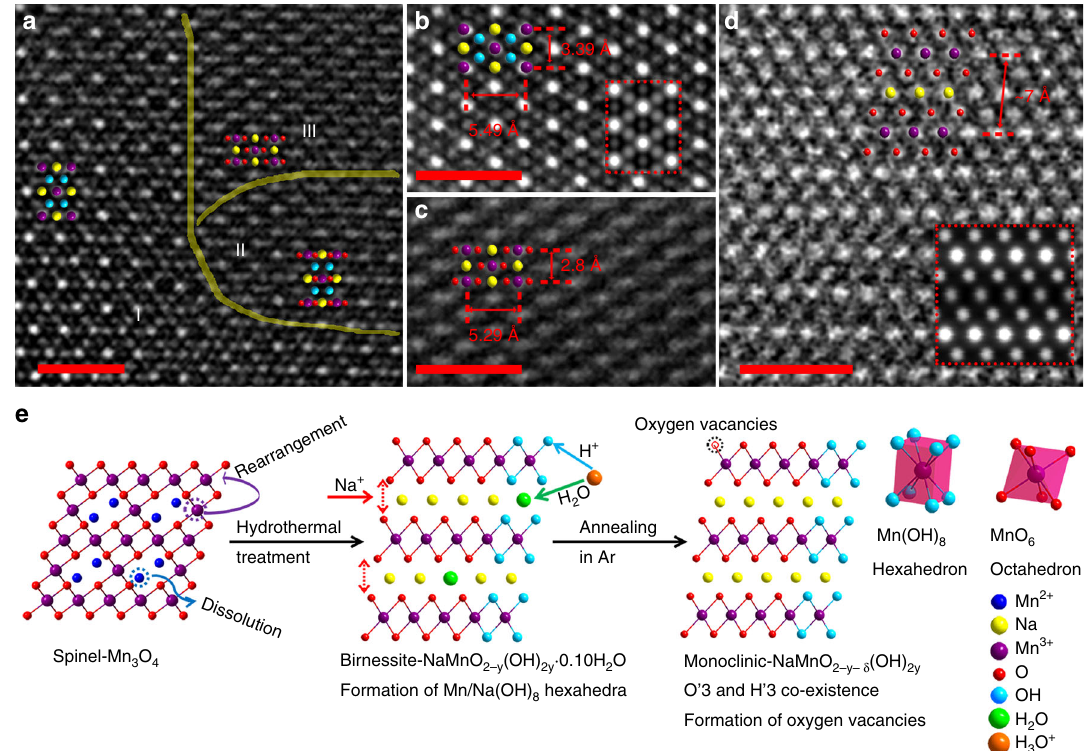
Fig. 3 STEM images and formation mechanism. a – c HAADF-STEM images for the S4 sample along [001] zone axis; Scale bar, 1 nm (I, H ′ 3 stacking zone; II, intermediate H ′ 3/O ′ 3 stacking zone; III, O ′ 3 stacking zone). d HAADF-STEM image for the S4 sample along [010] zone axis; Scale bar, 1 nm. e Schematic illustration of the phase transition from spinel-Mn 3 O 4 to monoclinic-NaMnO 2 – y – δ (OH) 2 y . The simulated HAADF images along [001] and [010] zone axis are inserted in b and d , as outlined by red dotted frames,